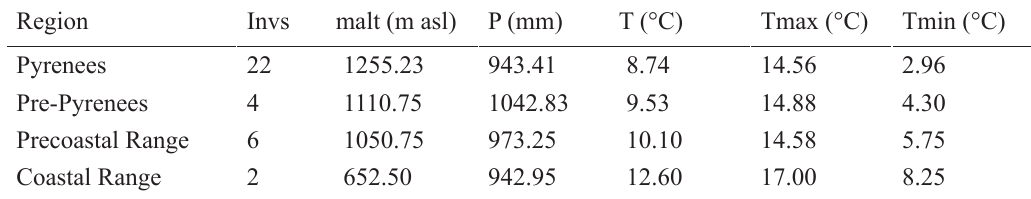
annual temperature; Tmax, mean maximum annual temperature; Tmin, mean minimum annual